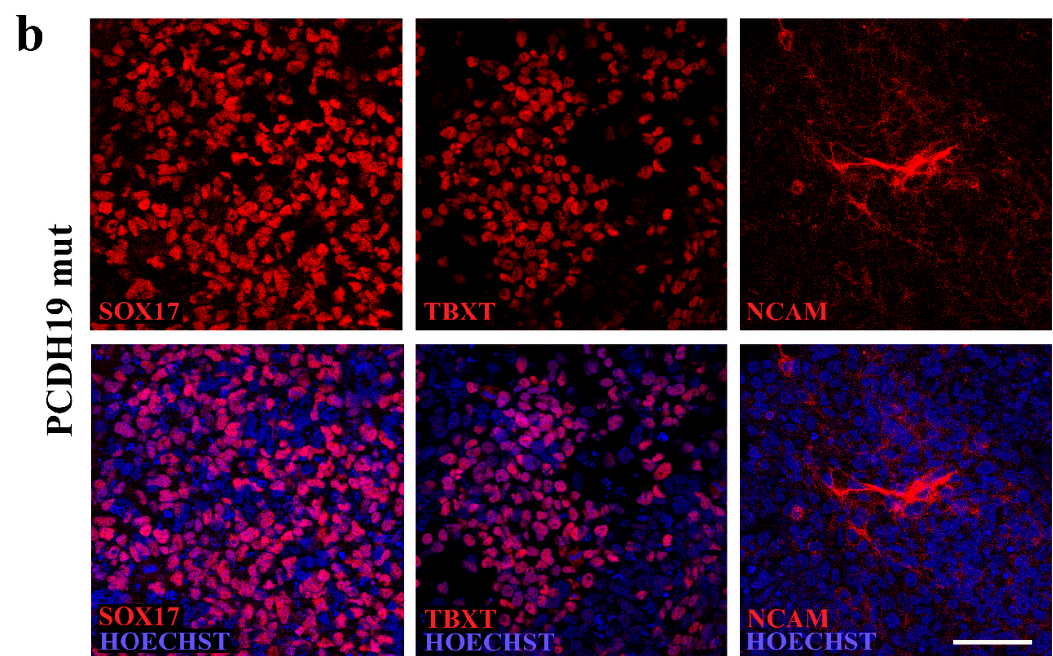
Figure 2. Characterization of the pluripotency ability of the selected iPSC clones. ( a , b ) Confocal micrographs of immunofluorescence analyses performed following differentiation into the three germ layers. The images show the expression of endoderm (SOX17), mesoderm (TBXT) and ectoderm (NCAM) markers in CTRL ( a ) and PCDH19mut ( b ) iPSCs. Scale bar = 50 μ m.